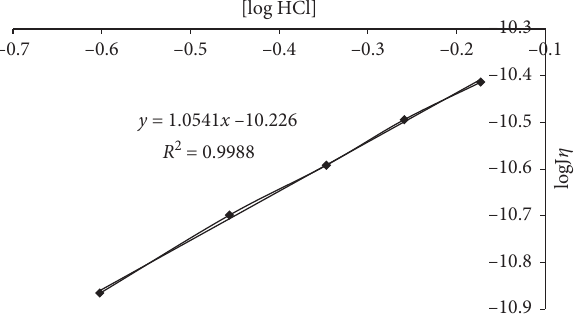
Figure 5: Plot of log [HCl] versus log J η (the same operating conditions as given in Figure 4).